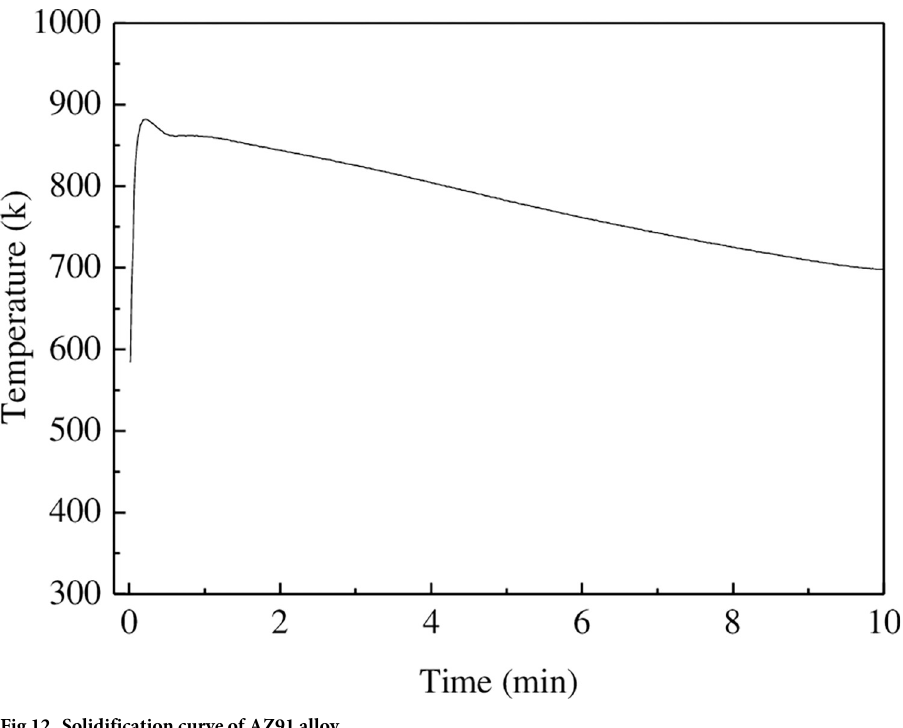
Fig 12. Solidification curve of AZ91